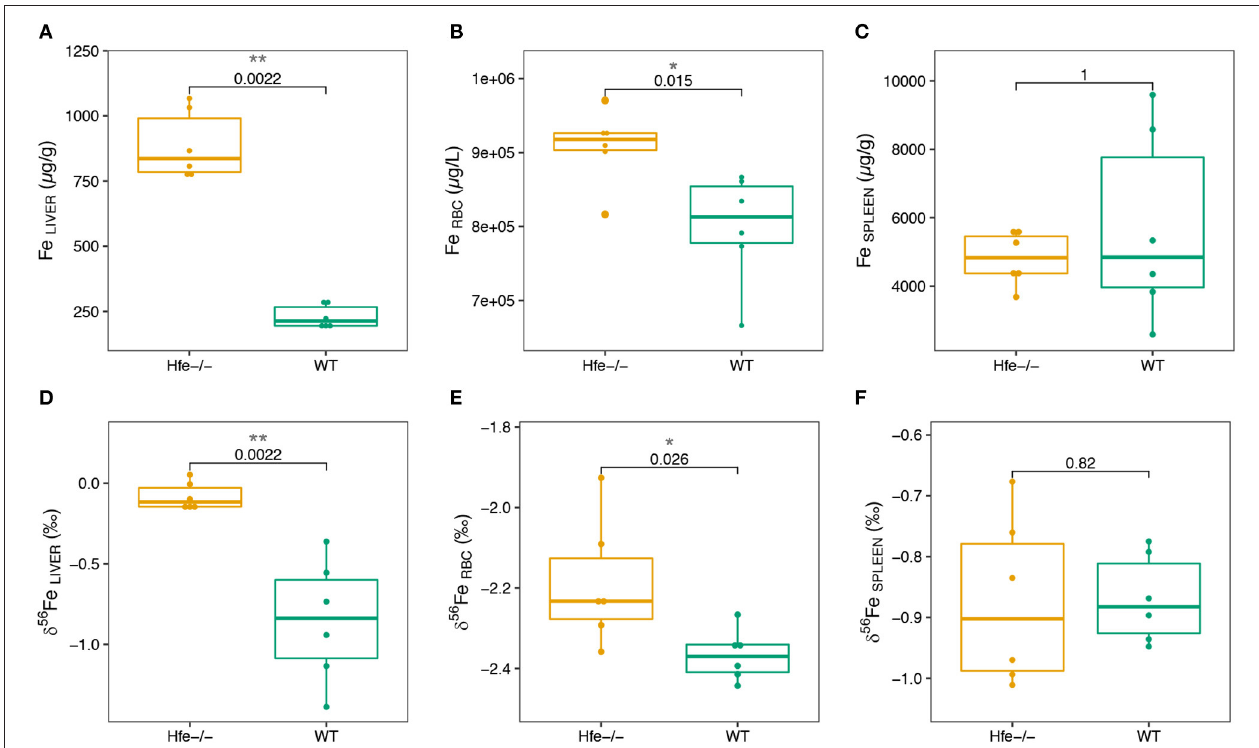
FIGURE 2 | Boxplots of Fe concentration in organs of the H fe − / − mouse model compared to the WT group (A–C) and of Fe isotope composition in organs of the H fe − / − mouse model compared to the WT group (D–F) . RBC stands for erythrocytes. The P -values of Wilcoxon test and associated significance (*** P < 0.001, ** P < 0.01, * P < 0.05) are